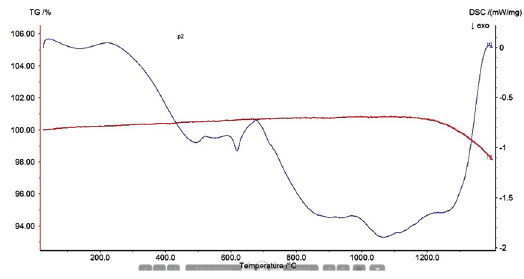
Figure 6: TGA of Pr 3+ (x=10 % and x 1 = 0.5 %) doped borate glass.